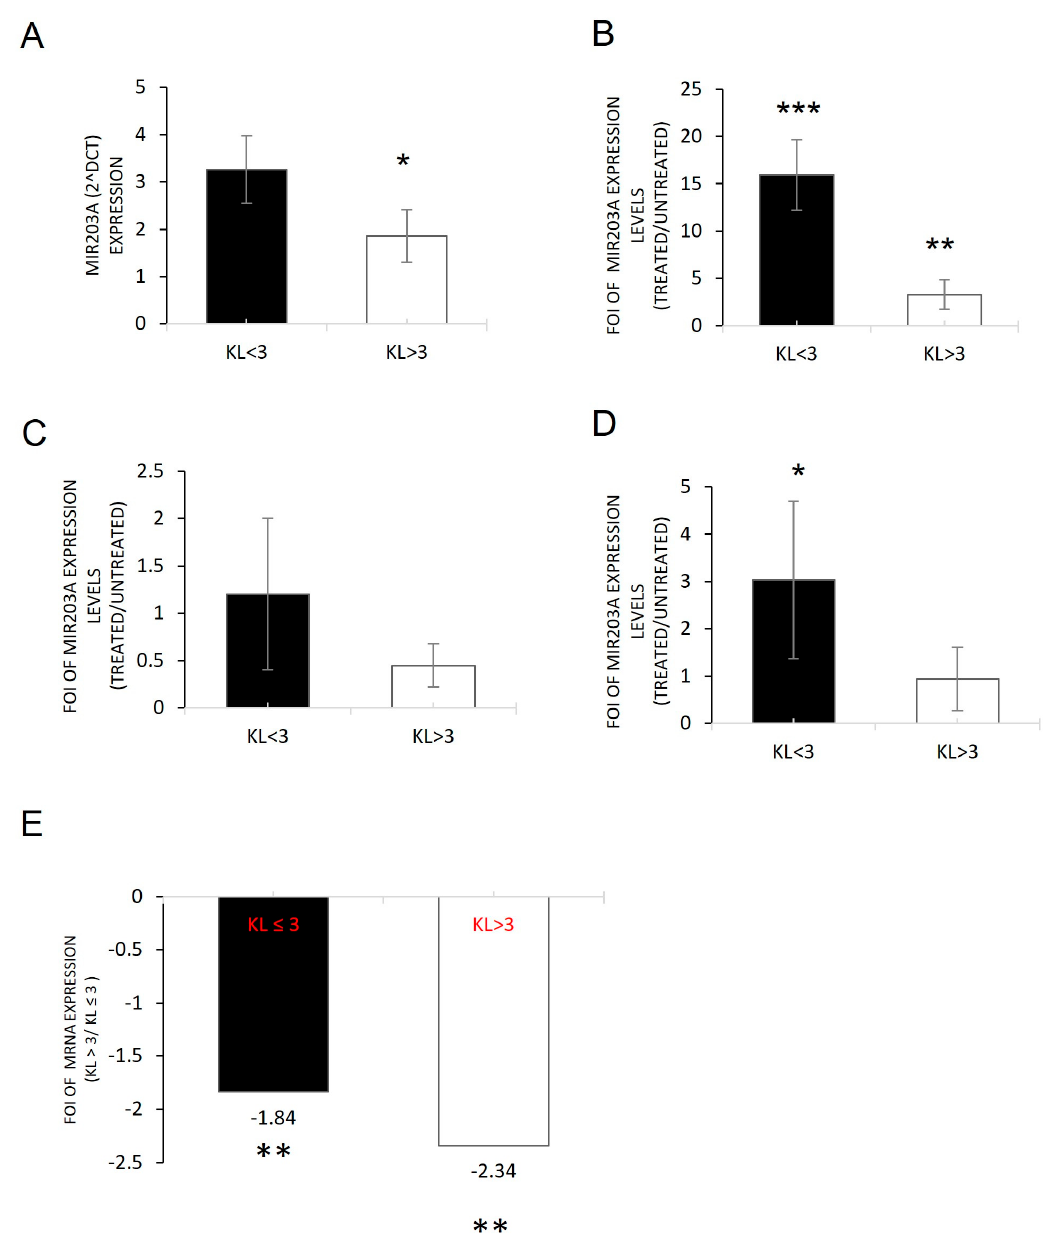
Figure 2. miR203a-3p expression and modulation in osteoblasts derived from OA patients. qRT-PCR analysis of miR203a-3p basal expression on OBs derived from the KL > 3 group and the KL ≤ 3 group. Data are reported as 2 − ∆ t (mean ± SD, n = 4). Student’s t -test *, t = 3.12, p = 0.021 ( A ). miR230a-3p expression analysis on ( B ) OB-derived cells after treatment with IL-1 β , ( C ) after transfection with miR203a-3p inhibitor, and ( D ) after co-treatments IL-1 β and miR203a-3p inhibitor. Data are reported as FOI of expression between treated and untreated samples. ( E ) qRT-PCR analysis of miR203a-3p expression in OBs co-treated with IL-1 β and miR203a-3p inhibitor. Data are reported as FOI of expression between co-treated cells compared with IL-1 β -treated cells (mean ± SD, n = 4). One-way ANOVA (KL ≤ 3: F = 48.2 p < 0.0005; KL > 3: F = 7.30, p = 0.002); multiple comparisons versus untreated (* p < 0.05; ** p < 0.005; *** p <